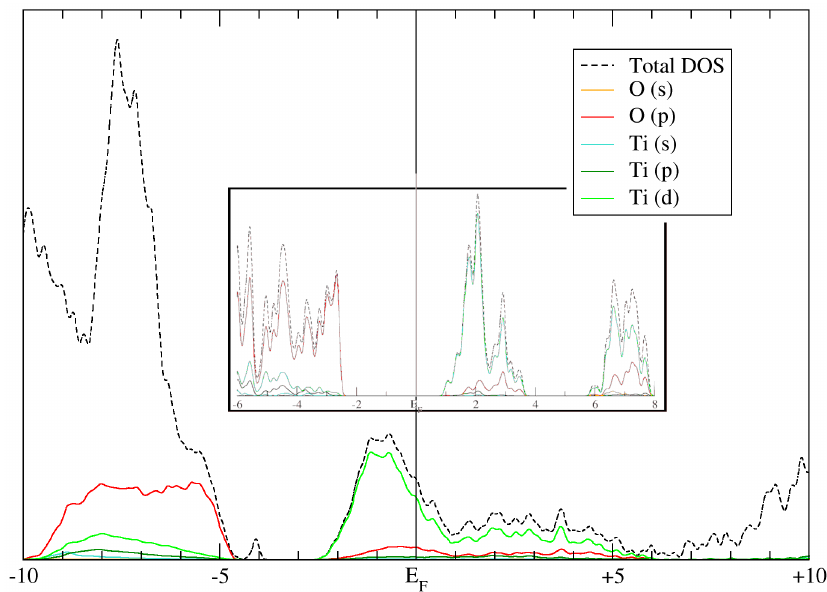
Figure 9. Shell-resolved partial EDOS of the nanoparticle system, with the corresponding EDOS for bulk anatase inset. The y-axis is the number of states occurring at that energy level.